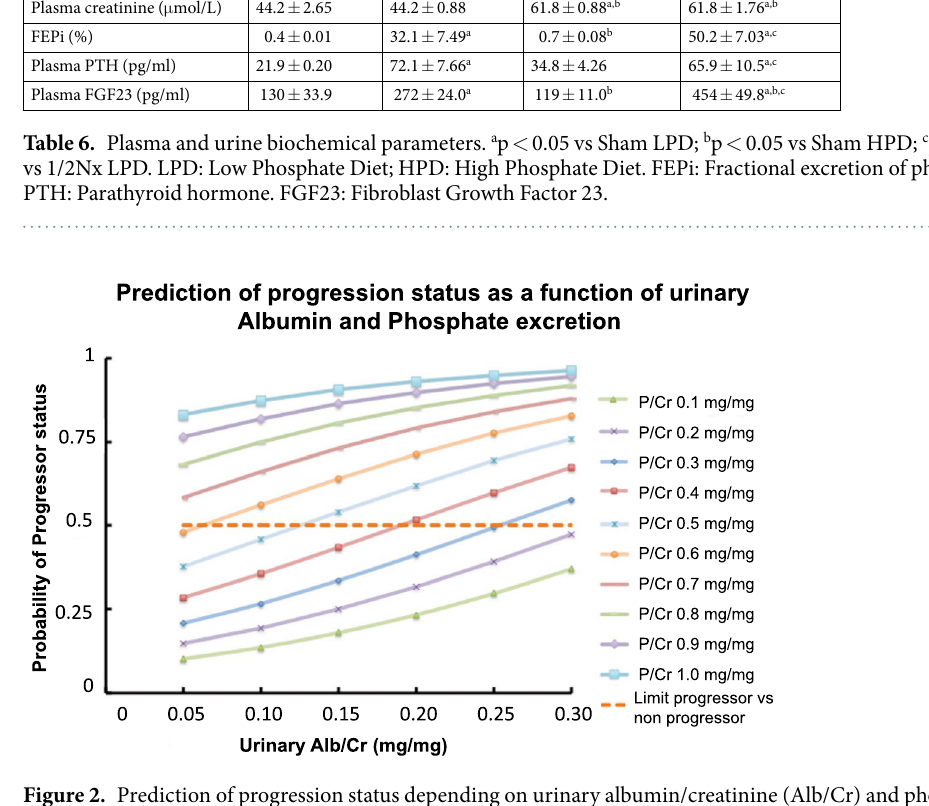
Sham LPD Sham HPD 1/2Nx LPD 1/2Nx HPD Plasma phosphate (mmol/L)